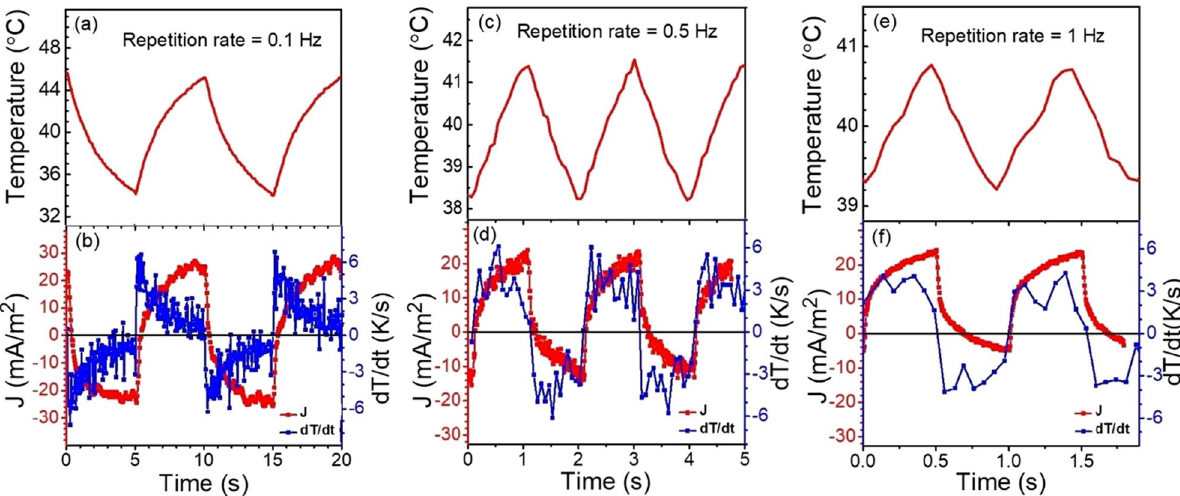
Figure 7. Temporal profile for temperature, its time derivative, and the corresponding pyroelectric current generated ( a , b ) for laser repetition rate 0.1 Hz, ( c , d ) for 0.5 Hz and ( e , f ) for 1 Hz, respectively. At a repetition rate of 0.1 Hz (5 s heating and cooling periods), the observed pyroelectric current is symmetric but at 1 Hz repetition rate (0.5 s heating and cooling periods) the positive current is unchanged and the negative current decreases but is non-zero.